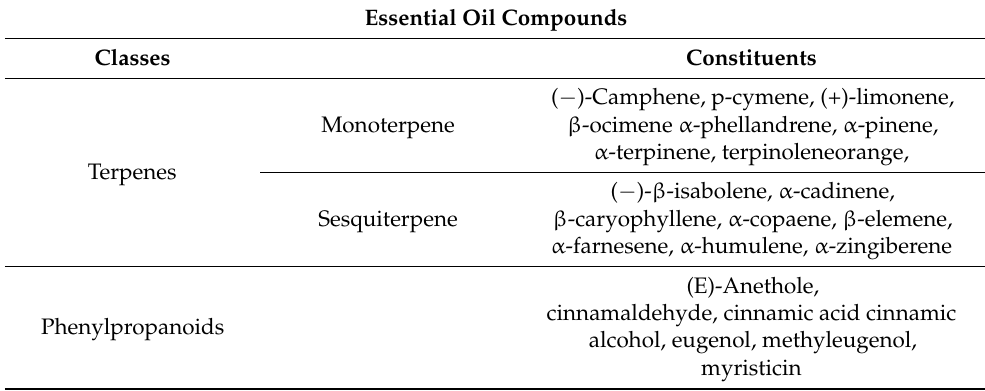
Table 1. Composition of compounds found in essential oils [29].